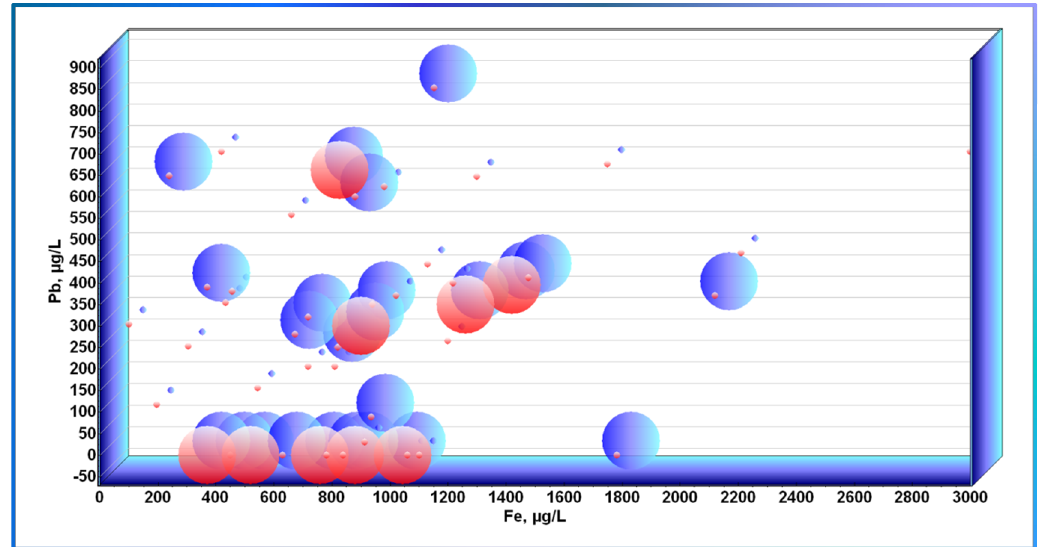
Figure 11. Bubble plot of the Pb and Fe concentrations combined interaction on TC ( blue ) and E. coli ( red ).